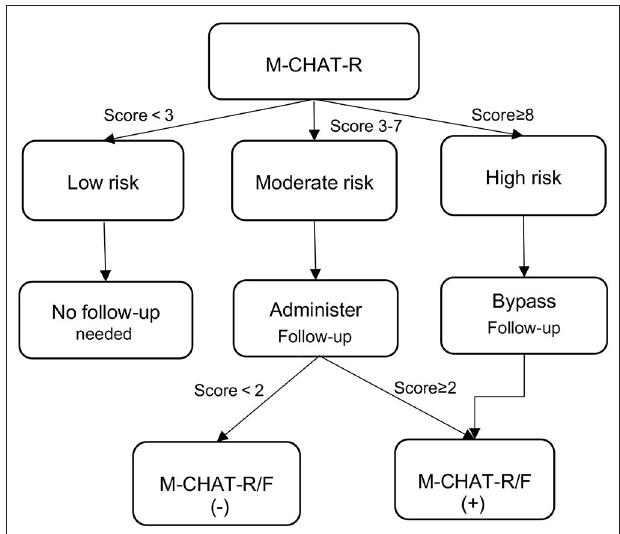
FIGURE 1 | Recommended algorithm based on 2-stage M-CHAT-R/F screening.